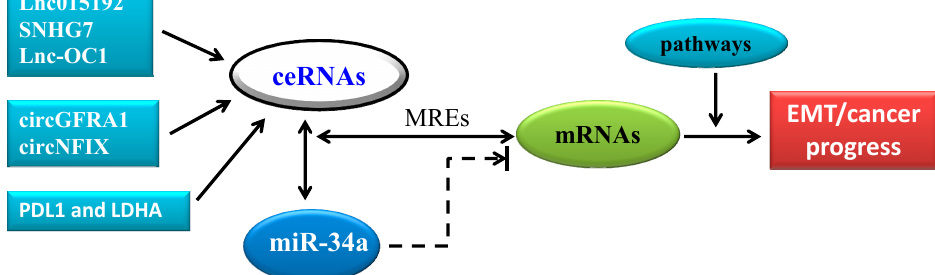
Figure 3. CeRNA in cancer progression: a new pattern of gene expression regulation sponging miR-34a. The lncRNAs, including lnc015192, SNHG7, and lnc-OC1; circ RNAs including circGFRA1 and circNFIX; and coding RNA including PDL1 and LDHA, can function as ceRNAs through MREs to regulate target gene expression by sponging miR-34a, for EMT in cancer progression and metastasis. Note: solid arrow indicates the major pathways, whereas dashed arrow indicates another regulatory pathway.